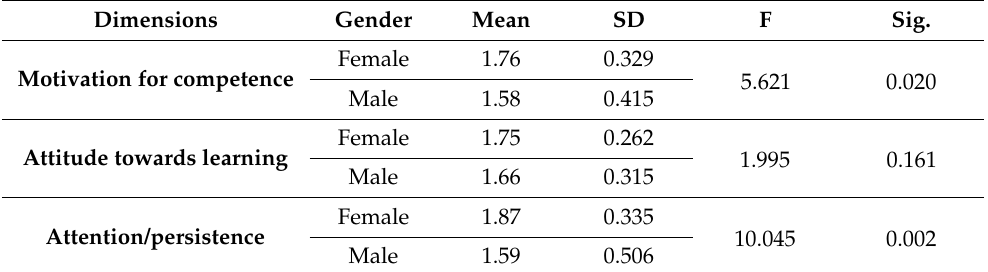
Table 3. ANOVA for learning and gender.